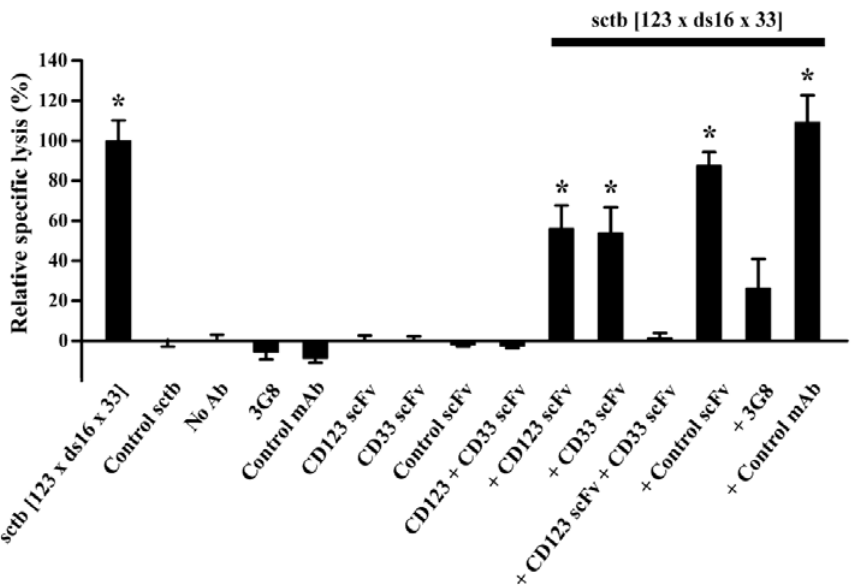
Figure 3. Antigen-specific induction of ADCC in the double-positive AML cell-line MOLM-13 by sctb 123-ds16-33. The sctb induced strong ADCC of MOLM-13 cells at a concentration of 1 nM. Simultaneous addition of a 500-fold molar excess of CD33- and CD123-specific scFvs each completely blocked the ADCC reaction, but the addition of ei- ther the CD33- or the CD123-specific scFv alone, or a control scFv, did not. Simultaneous incubation with a 125-fold molar excess of a CD16-specific antibody—but not with a con- trol IgG1—significantly reduced ADCC. Data points represent mean percentage of relative specific lysis obtained with isolated mononuclear cells (MNCs) from six different unrelat- ed healthy human donors at an E:T ratio of 40:1. Specific lysis measured for the sctb was set to 100%, background lysis occurring in the absence of added sctb or antibody (Ab) was defined as 0%, and specific lysis was calculated as total minus spontaneous lysis. The * symbol designates statistically significant differences ( p < 0.05) in ADCC relative to the control sctb. From Kügler 2011 [11] with